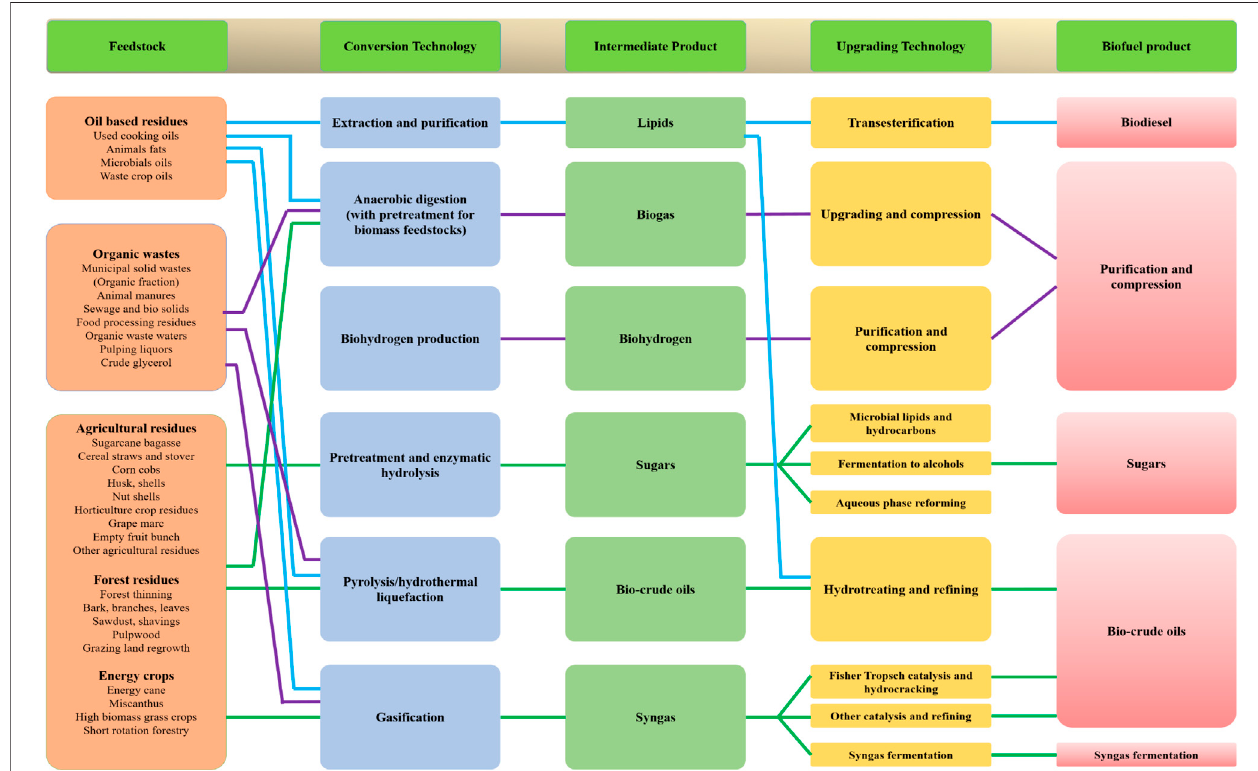
FIGURE 1 | Pathways to convert different waste types into energy (O ’ Hara and Melssen, 2013).